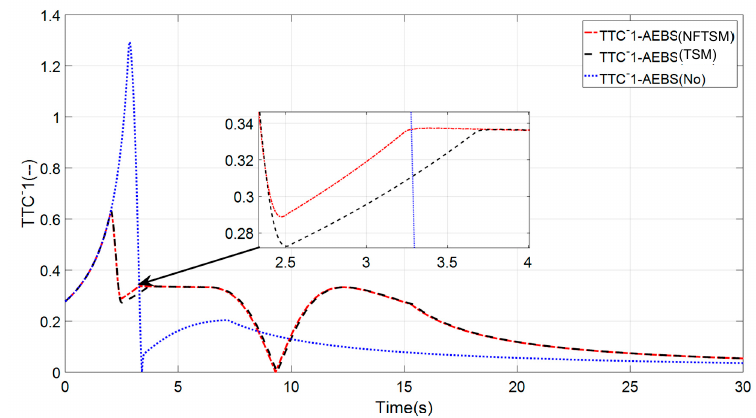
Figure 19. Comparison of vehicle acceleration.